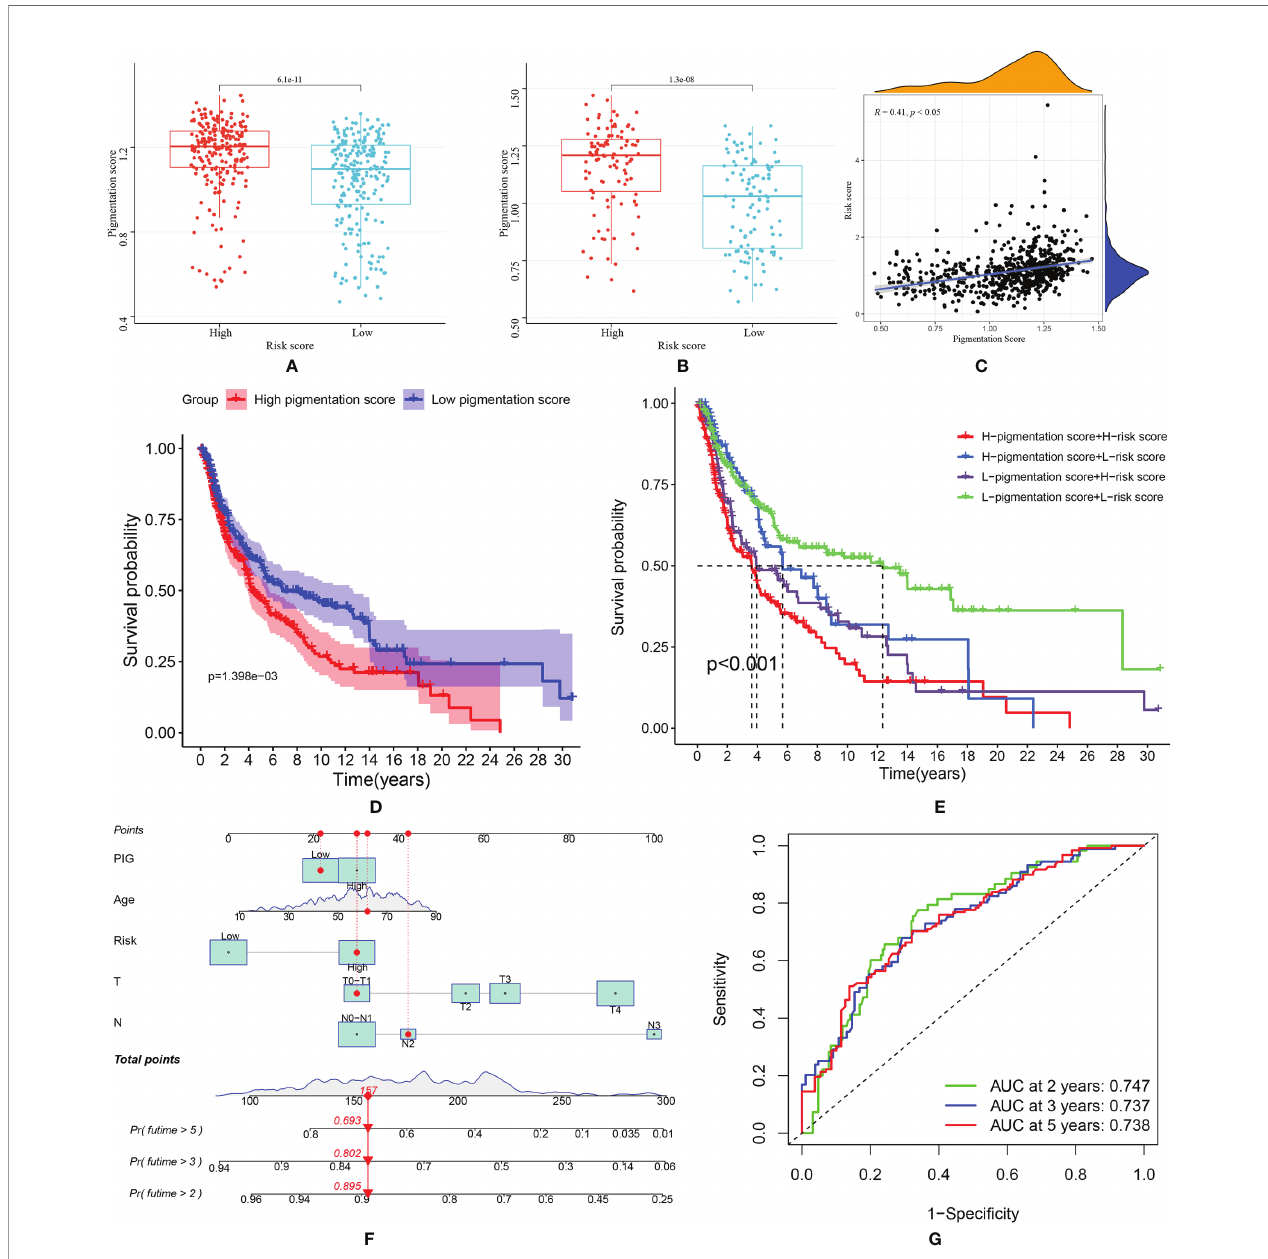
FIGURE 7 | (A) Comparison of pigmentation score in high and low-risk score patients from TCGA dataset; (B) Comparison of pigmentation score in high and low- risk score patients from GEO dataset; (C) Correlation between risk score and pigmentation score; (D) Kaplan – Meier (KM) curves of overall survival of high and low- pigmentation score groups; (E) The survival curves of SKCM patients based on risk score and pigmentation score; (F) The nomogram was constructed based on pigmentation score, age, risk score, T and N stage; (G) The ROC curve of nomogram model predicting 2-, 3- and 5-year